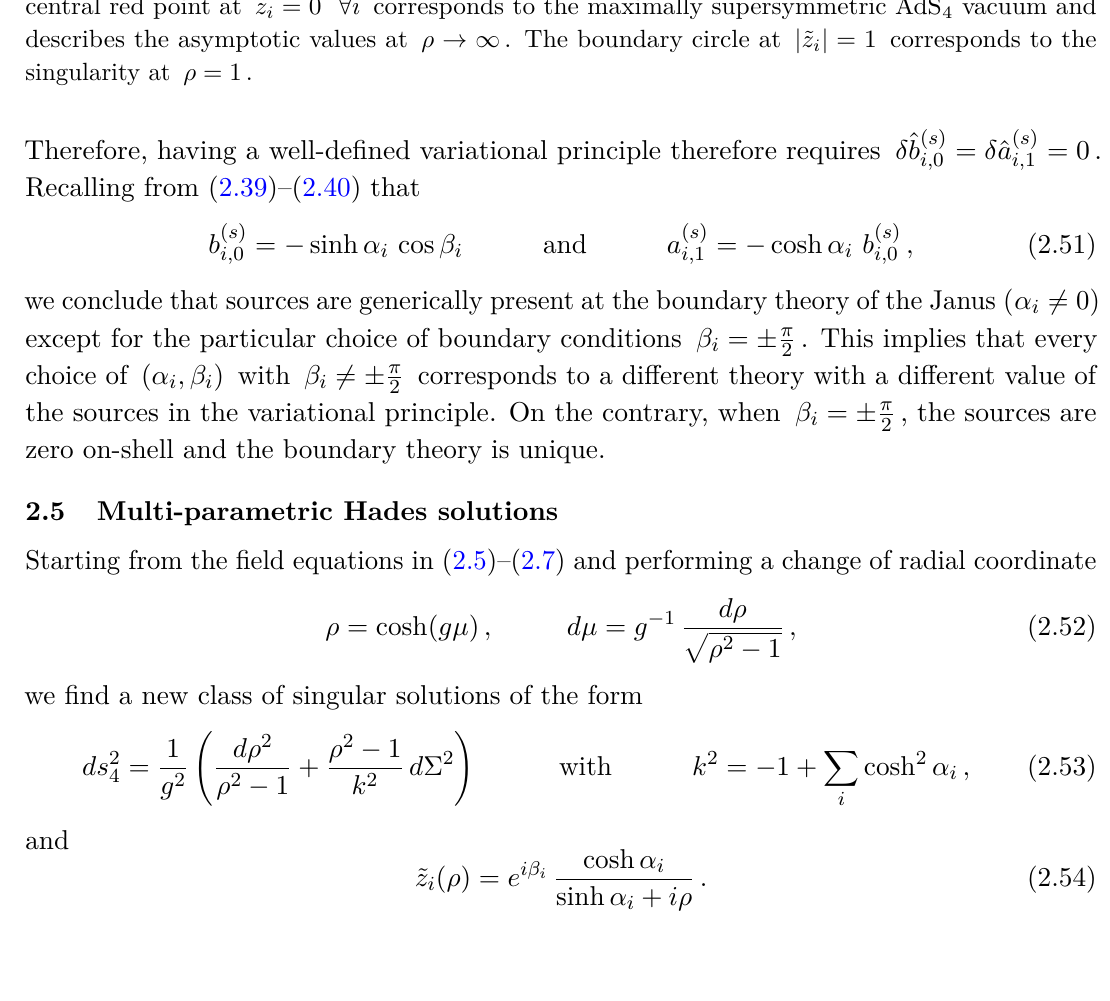
with n = 0 , . . . , 7 . The 4